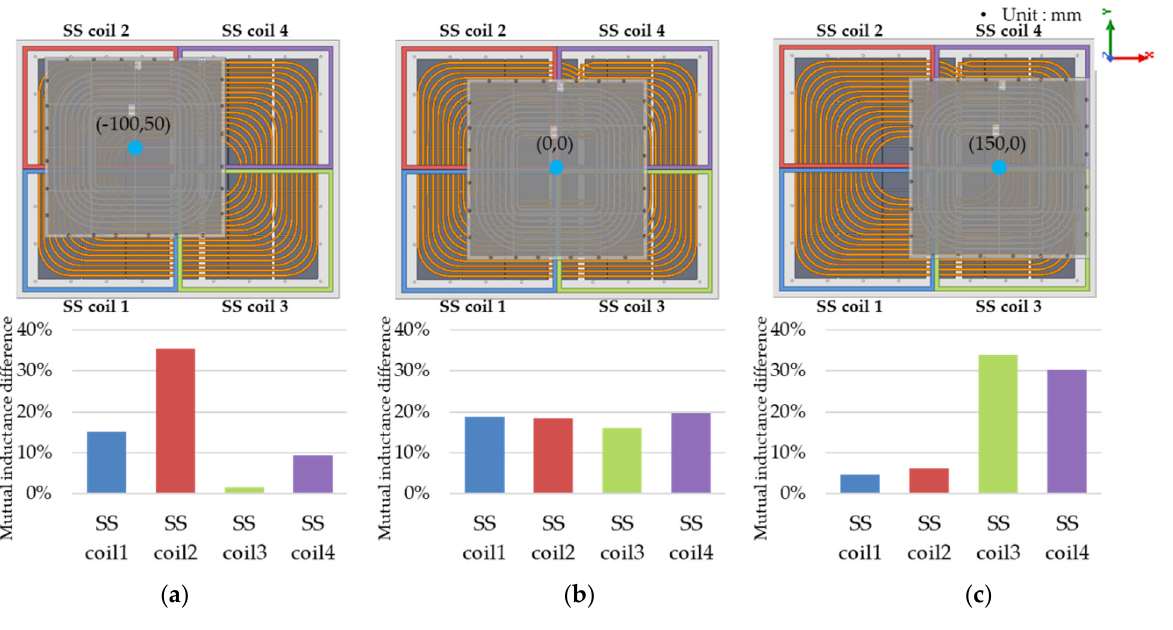
Figure 17. Experimental results of the position-detection performance: ( a ) Receiver position: ( − 100,50); ( b ) Receiver position: (0,0); ( c ) Receiver position: (150,0). ( − 100,50); ( b ) Receiver position: (0,0); ( c ) Receiver position: (150,0).